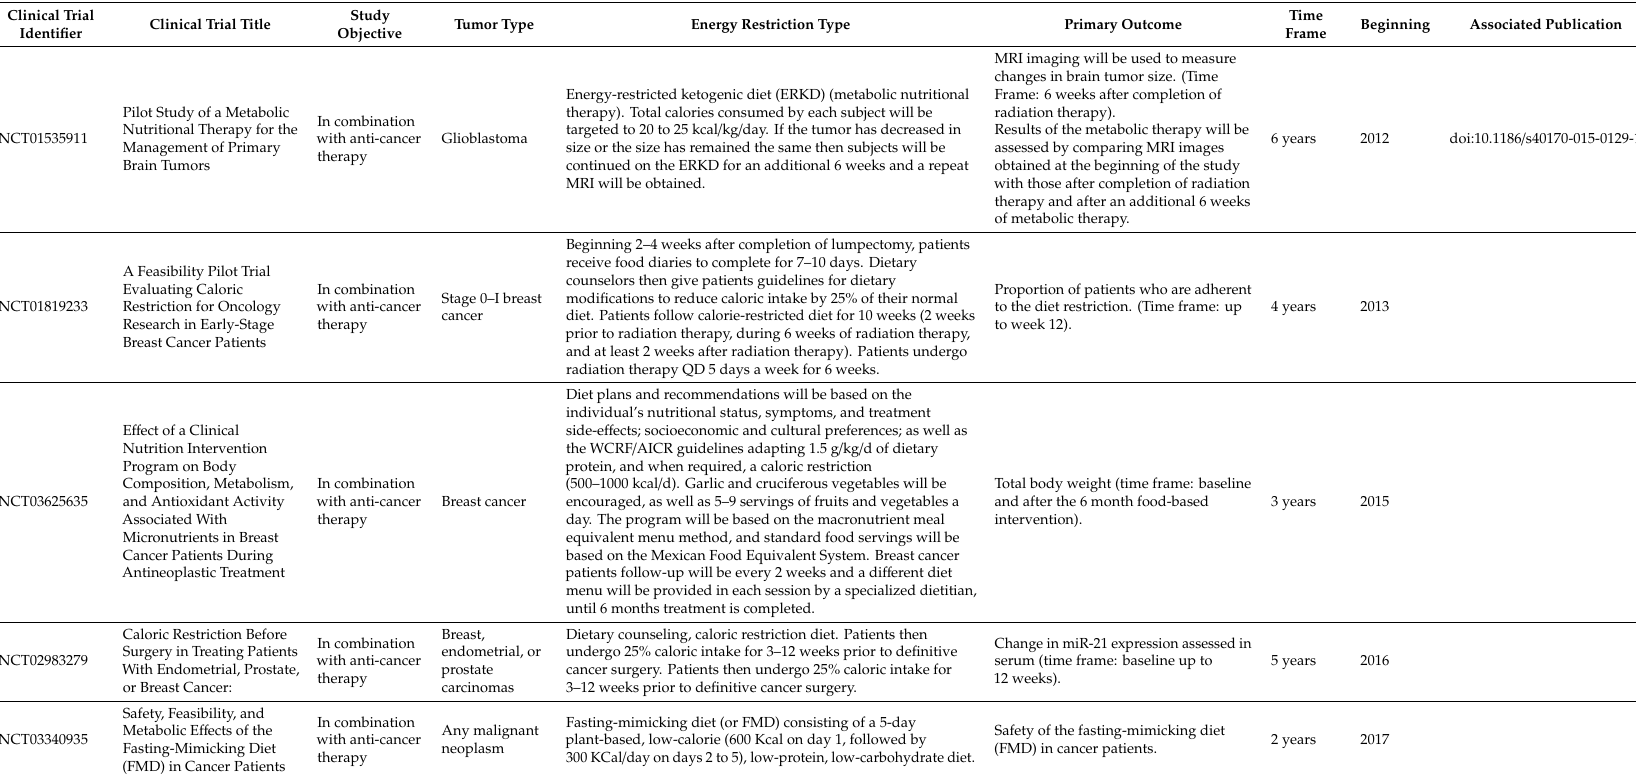
Table 1. Clinical trials on energy restriction (ER) and cancer. Clinical trials posted in the ClinicalTrials.gov public database including the keywords “diet”, “fasting”, “cancer”, “energy restriction”, “calorie restriction”, or “caloric restriction”. The list includes trials with a well-defined ER intervention, either as a preventive strategy or in combination with anti-cancer treatment (chemotherapy, radiotherapy, surgery, or a combination of these strategies). Note: QD = once daily; WCRF / AICR = World Cancer Research Fund / American Institute for Cancer Research; CLS = macrophage crown-like structures; FACT-G / O / P = Functional Assessment of Cancer Therapy-General / Ovarian / Prostate; HER2 = human epidermal growth factor receptor 2; ACSM = American College of Sports Medicine; NSCLC = non-small cell lung cancer; RECIST = Response Evaluation Criteria in Solid Tumors; DPP = Diabetes Prevention